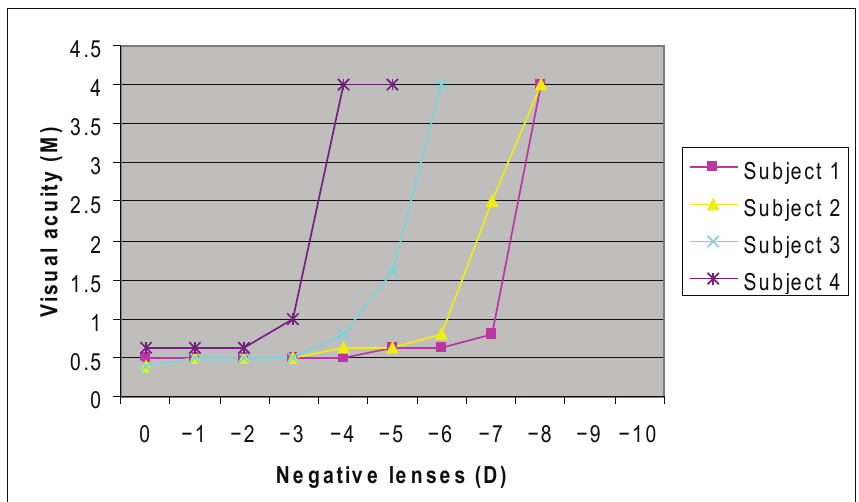
Figure 10. Effect of negative lenses on visual acuity while viewing a near acuity chart at 0.4 m without a pinhole and illuminated of 1 lux.